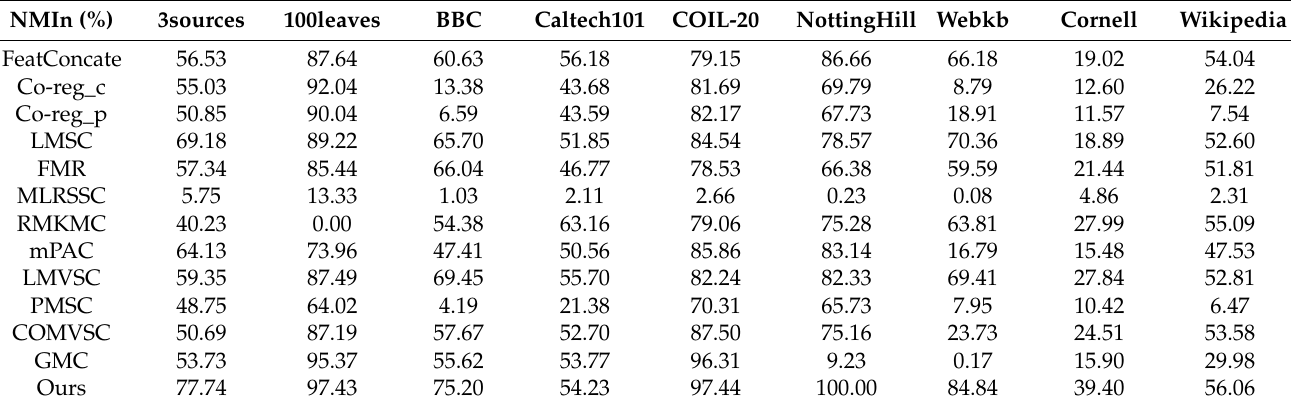
Table 4. The clustering performance comparison in terms of NMI on nine multi-view data